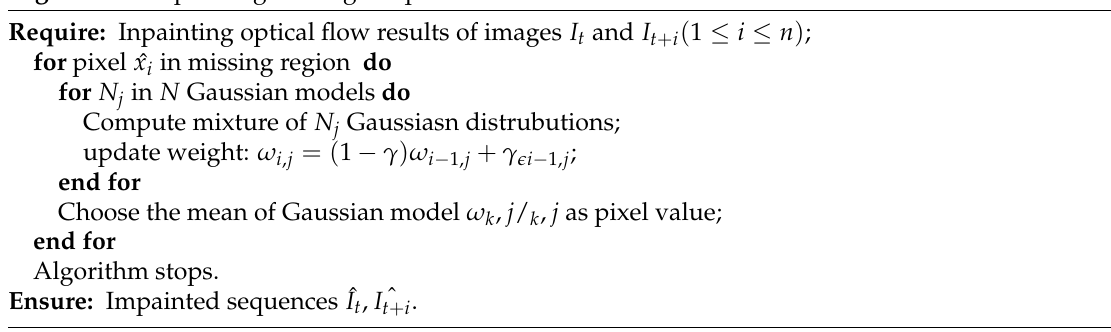
Algorithm 2 Inpainting of image sequences based on Gaussian mixture